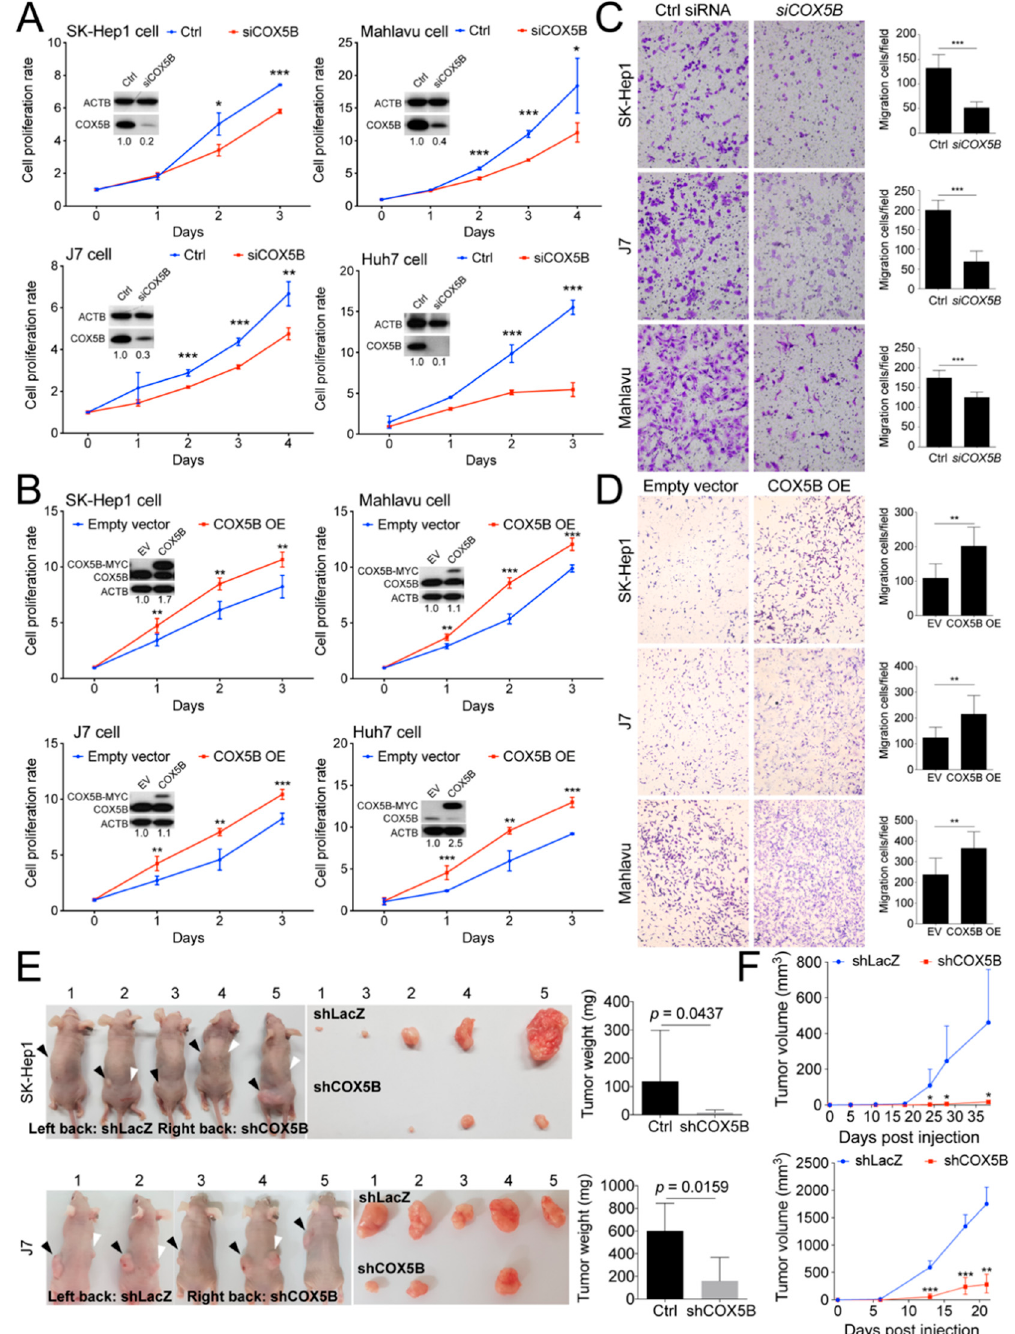
Figure 2. COX5B promotes hepatoma cell growth and migration. Assessment of growth curves in 4 independent hepatoma cell lines was conducted under ( A ) depletion or ( B ) over-expression of COX5B. The western blot images in ( A , B ) were all acquired by exposing the luminescent signals to X-ray films. The transwell assays were performed when ( C ) depletion or ( D ) over-expression of COX5B. ( E ) Representative images showing the xenografted tumors 3–6 weeks after implantation of the cells receiving control treatment (shLacZ) or knockdown of COX5B (sh COX5B ) in SK-Hep1 or J7 cells. The tumors were weighted and statistically compared (right panel). All the in vitro cell-based assays shown in ( A – D ) were conducted in duplicates. ( F ) The growth curve of the tumor volume over time was statistically compared. The p value was derived from paired two-tail student t -test. *, p < 0.05; **, p < 0.01; ***, p < 0.001.